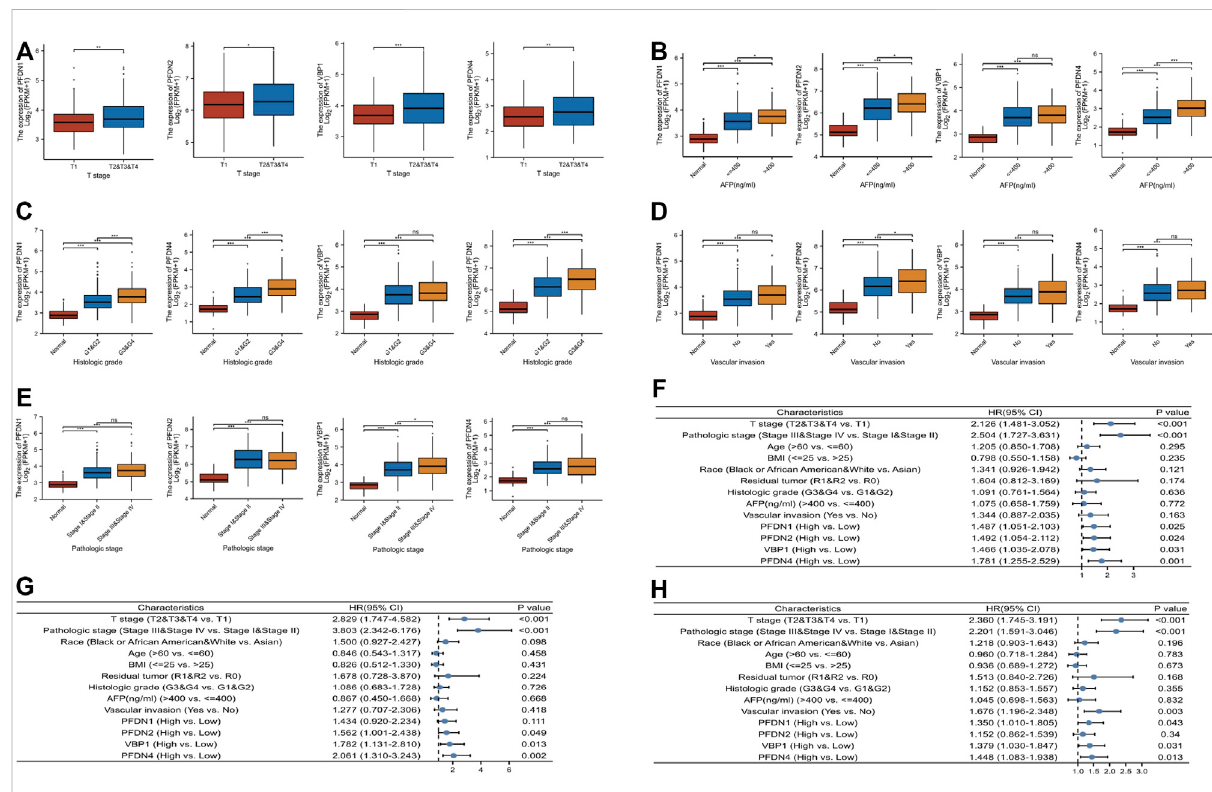
FIGURE 3 Relationship between mRNA expression of PFDN1/2/3/4 and clinical parameters of patients with HCC. The correlation between PFDN1/2/3/4 and (A) T stage, (B) AFP level, (C) histologic grade, (D) vascular invasion, and (E) pathologic stage. (F) PFDN1/2/3/4 has a prominent effect on OS. (G) PFDN2/3/4 has a prominent effect on DSS. (H) PFDN1/3/4 has a prominent effect on